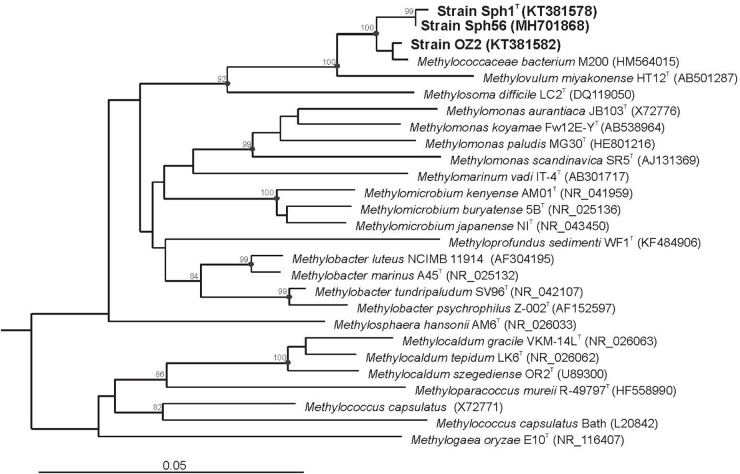
16S rRNA gene based neighbor-joining tree showing the phylogenetic position of strains Sph1T, OZ2 and Sph56 in relation to other members of the family Methylococcaceae. Bootstrap values (percentages of 1000 data resamplings) > 80% are shown. Black circles indicate that the corresponding nodes were also recovered in the maximum-likelihood and maximum- parsimony trees. The type II methanotrophs Methyloferula stellata AR4 (FR686343), Methylocella silvestris BL2 (AJ491847), Methylocapsa acidiphila B2 (AJ278726), Methylosinus sporium NCIMB 11126 (Y18946), Methylosinus trichosporium OB3b (Y18947) and Methylocystis parvus OBBP (Y18945) were used as an outgroup. Bar, 0.05 substitutions per nucleotide position.